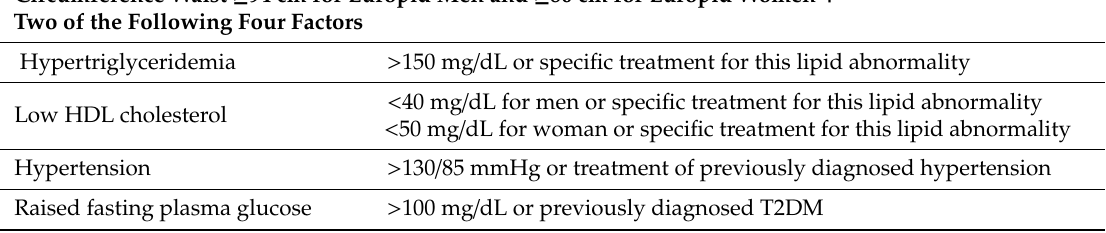
Table 1. IDF Metabolic syndrome